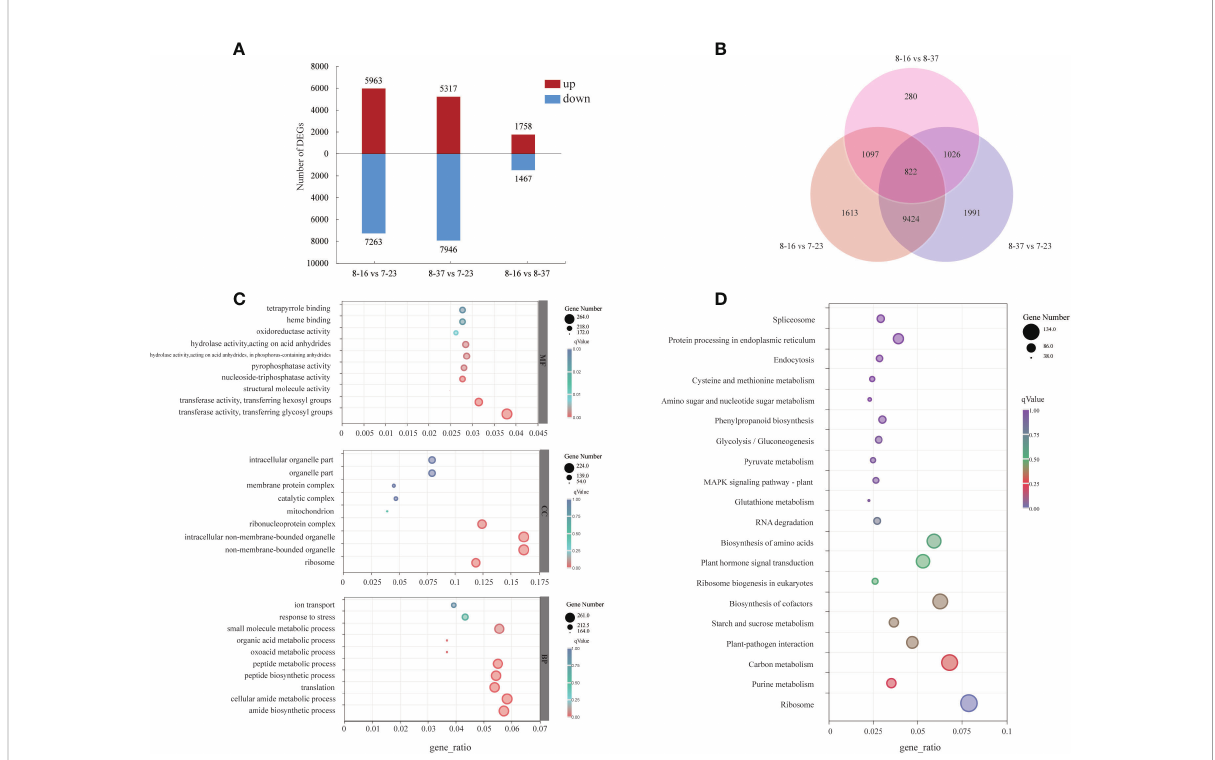
FIGURE 3 Distribution and annotation analyses of DEGs among three R. rugosa germplasms. (A) The number of up-regulated and down-regulated genes. (B) Venn diagram depicting the shared and speci fi c DEGs among three compare combinations. (C) GO classi fi cations of DEGs. (D) KEGG functional analysis of